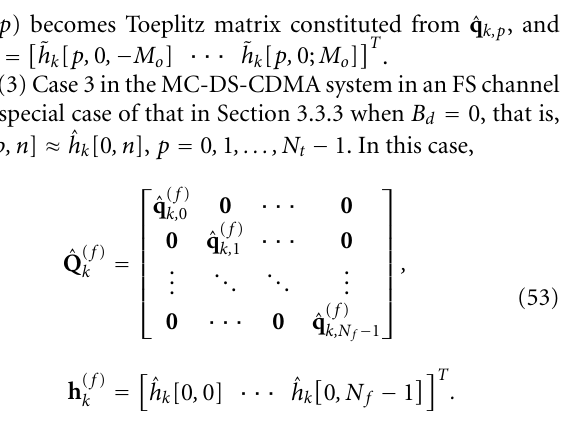
Figure 3: DS-CDMA and MC-CDMA systems in an FS channel. The DS-CDMA basis waveforms experience multipath dispersion in time due to frequency selectivity. The MC-CDMA system is diagonal since each subcarrier encounters nonselective fading in the frequency do-